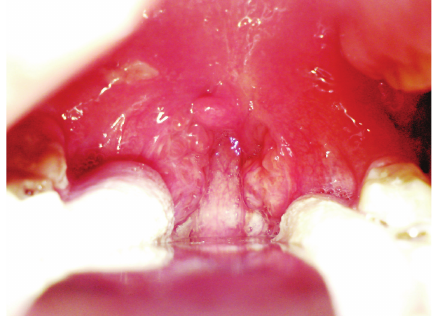
Figure 3: The bilateral Peritonsillar absesses in our case (12 hours after the initial incision and drainage which followed diagnostic needle aspiration). The incisions are still clearly